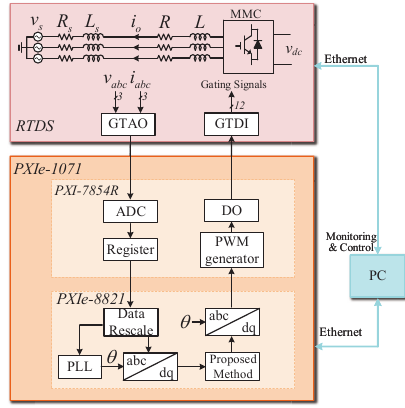
Figure 14. Block diagram of experimental setup.